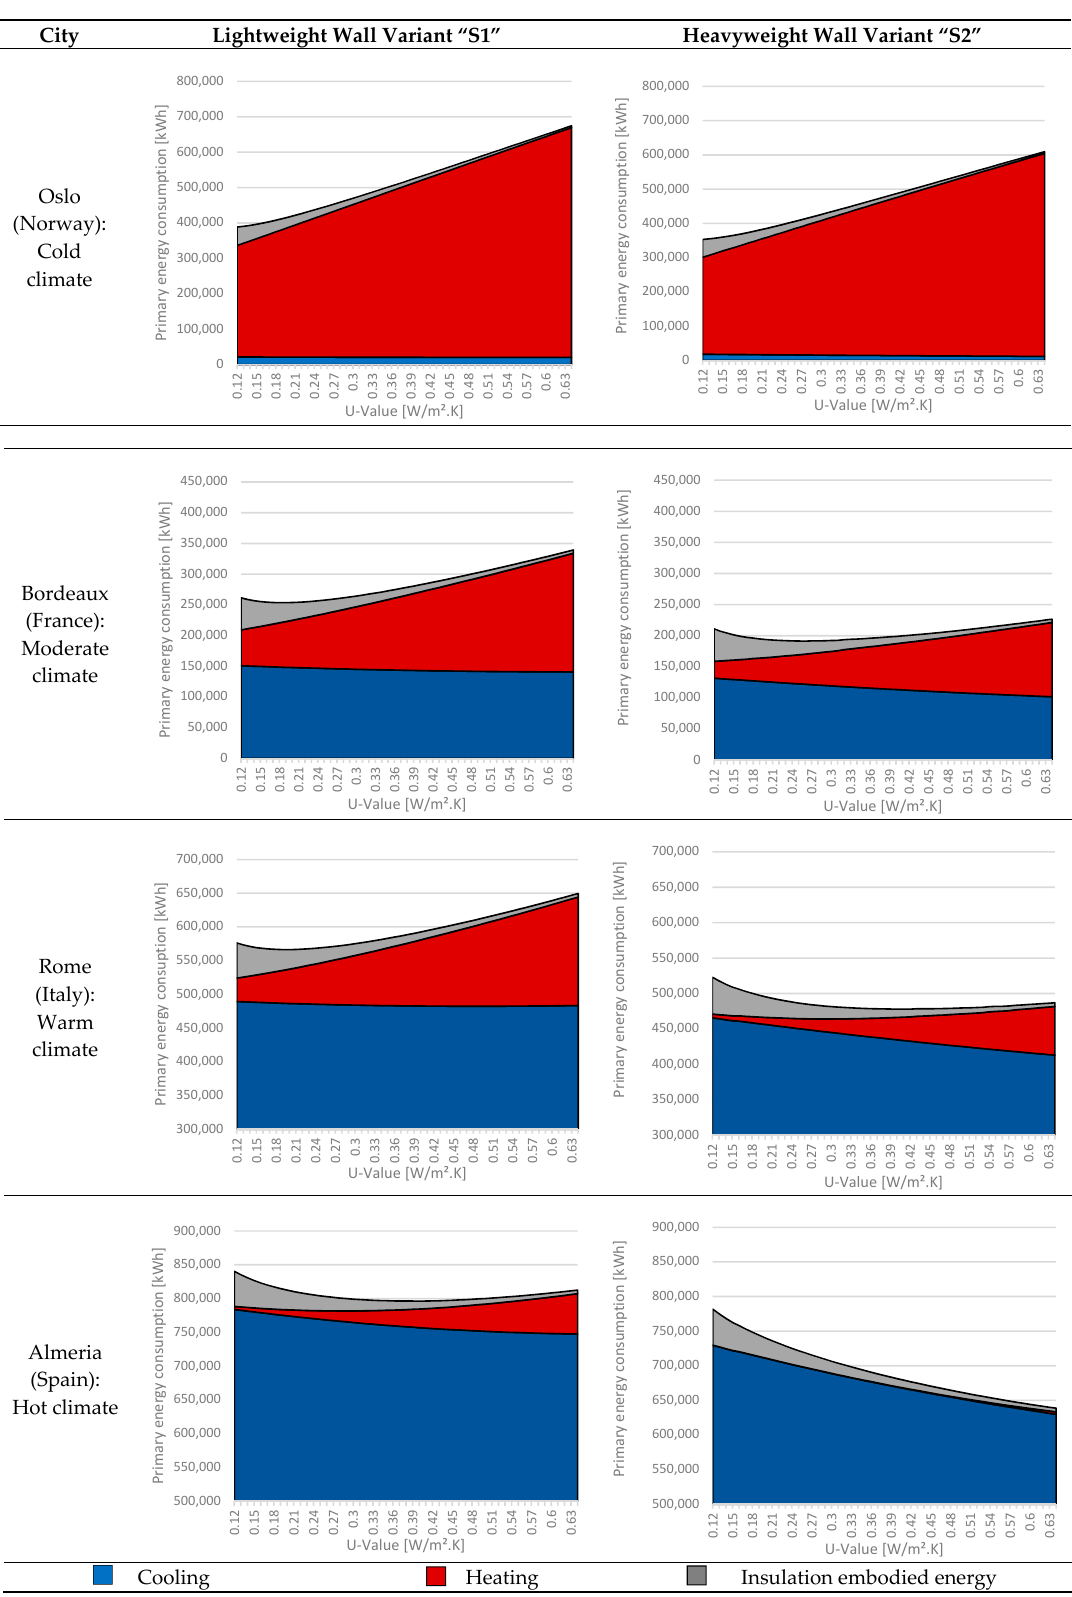
Figure 8. Building primary energy consumption in terms of heating and cooling for the four representative cities of the European context (Oslo, Bordeaux, Rome and Almeria). • Results for Oslo As reported in the charts, for both cases of lightweight S1 and heavyweight S2 solutions, the results show a great decrease in total energy consumption of about 50% from the upper to lower bounds of U-value. Moreover, the consumption due to operation only is reduced from 670 to 330 MWh, and from 605 to 300 MWh, respectively, considering the lightweight and heavyweight walls. Thus, it should be noted that the massive solution allows an energy saving of about 10% in comparison to the lightweight one. Due to the